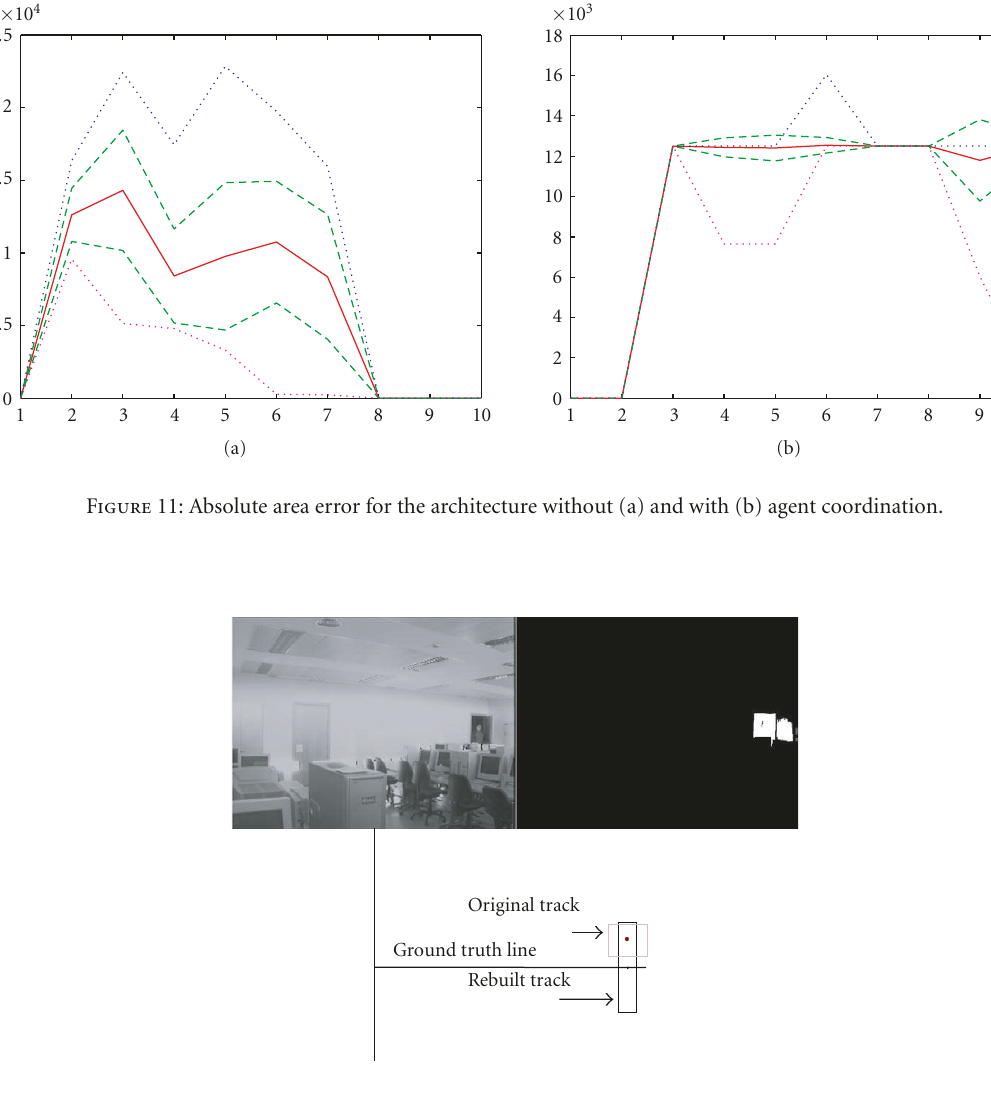
Figure 12: Reconstruction of the track based on previous